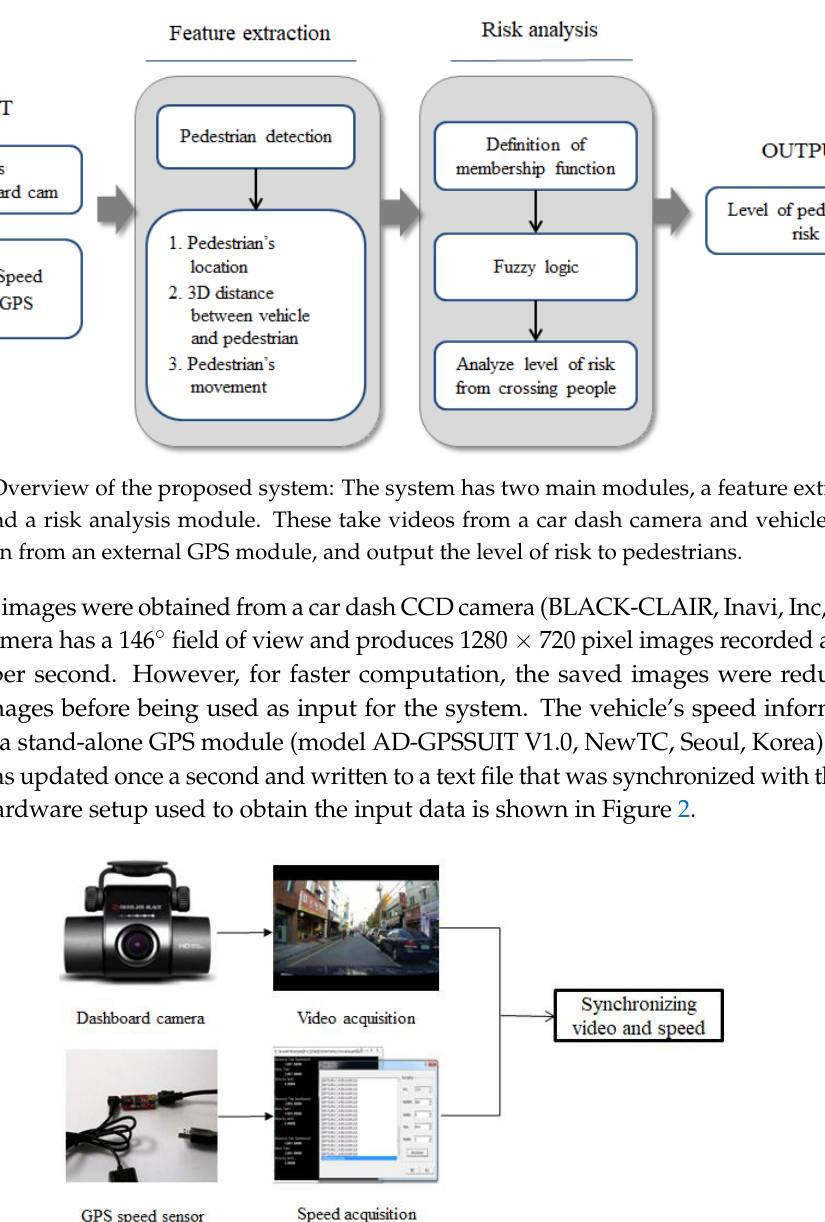
Figure 2. The speed information obtained from an external GPS module is written to a text file with the PC clock time. The speed information is synchronized with the video input from the on-dash camera in a car using the PC clock time afterwards.